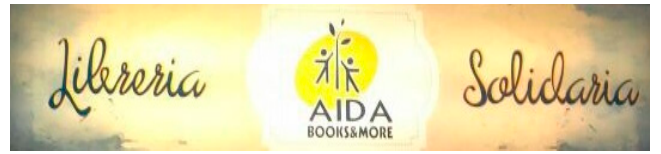
Figure 37. Valencia: Spanish-English sign on a bookshop.